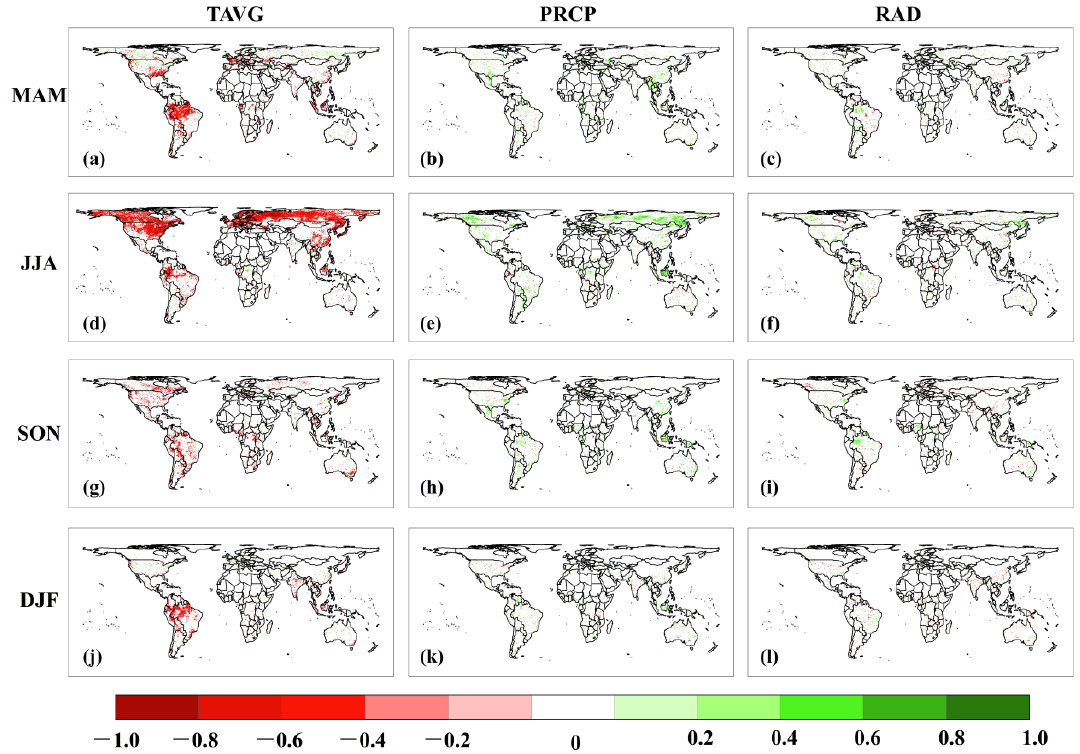
Figure 7. Spatial pattern of the partial correlation coefficients between CUE and TAVG, PRCP, and RAD in ( a – c ) MAM, ( d – f ) JJA, ( g – i ) SON, and ( j – l ) DJF. Shown are significant correlations ( p < 0.01).